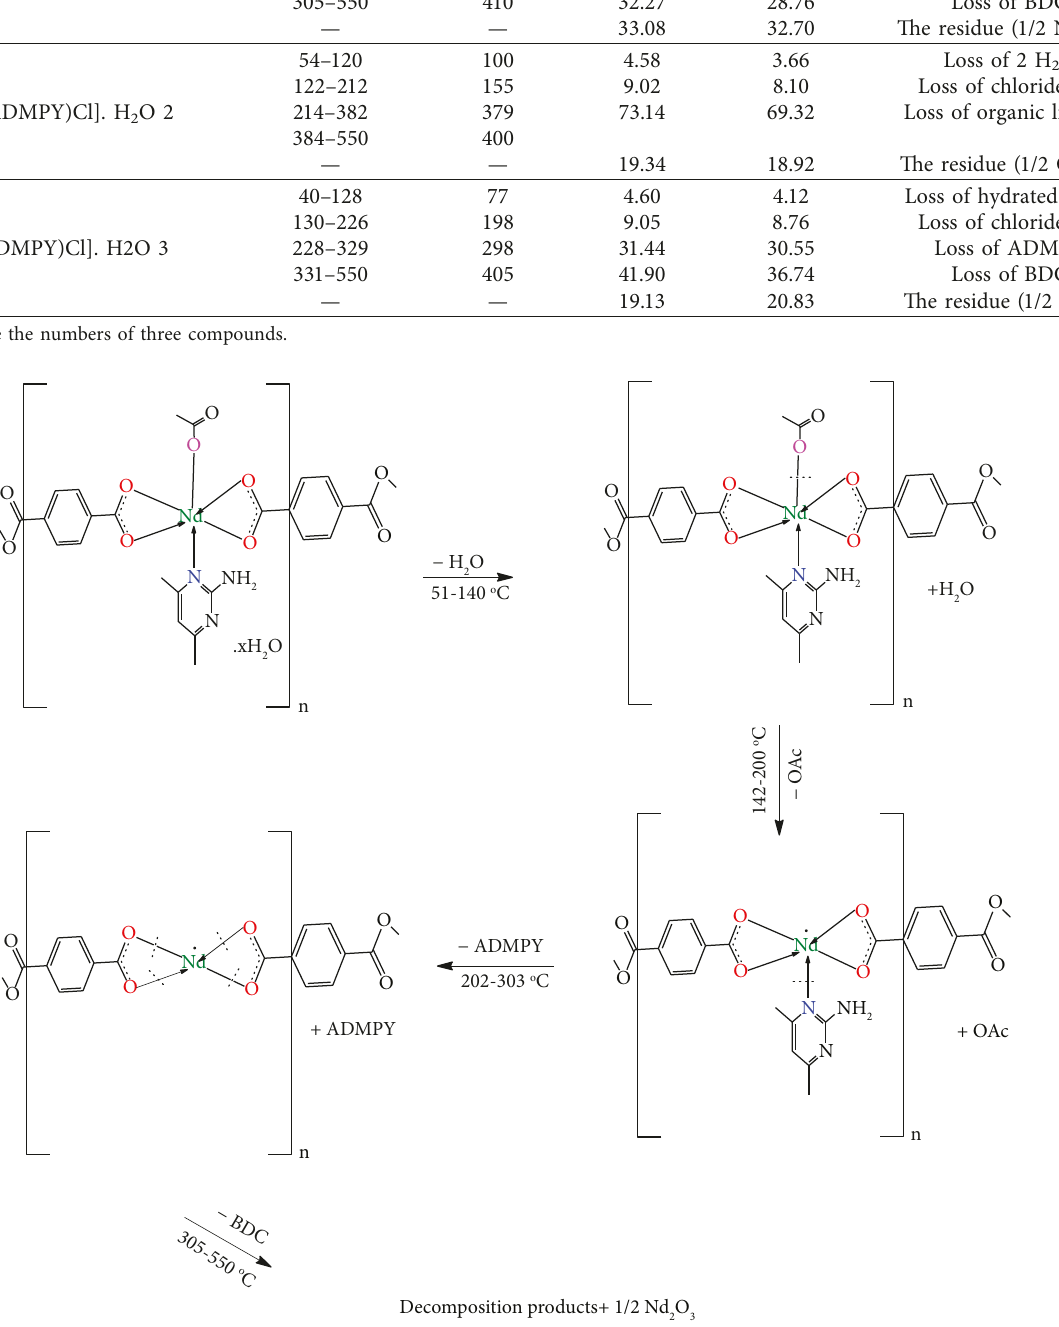
Scheme 1: Decomposition of Nd(III) compound in dynamic